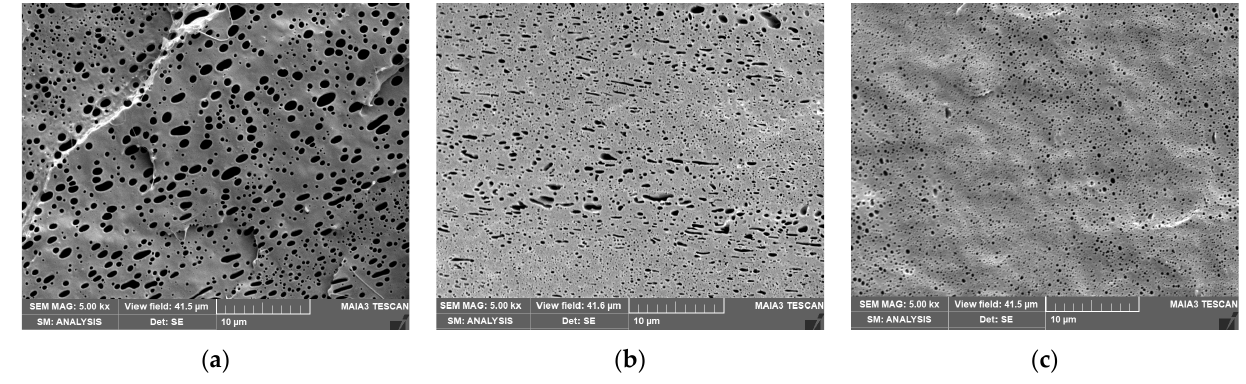
Figure 2. SEM images of PLA/PCL 20/80 with ( a ) PLA treated with DMF, ( b ) PCL/CNC masterbatch, and ( c ) PCL/CNCd masterbatch; the dark voids represent NaOH-etched PLA inclusions.